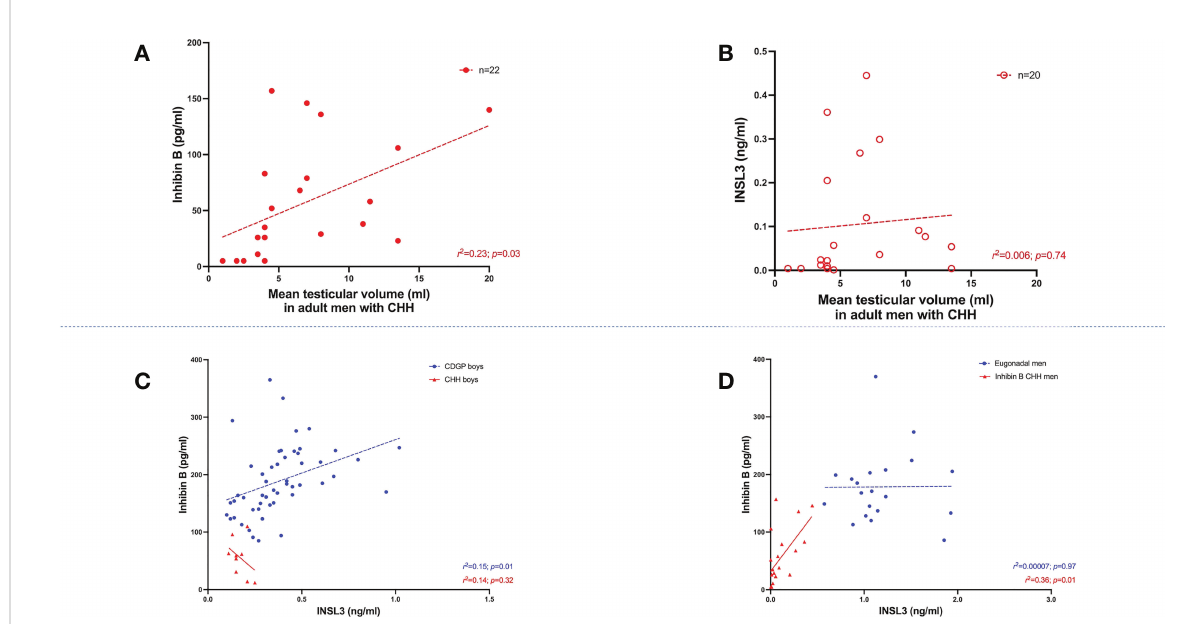
FIGURE 2 (A) Relationship between INB (pg/ml) and mean testicular volume (ml) in adult men with CHH ( n =22). Simple linear regression r 2 = 0.23; p =0.03. (B) Relationship between INSL3 (ng/ml) and mean testicular volume (ml) in adult men with CHH ( n =20). Simple linear regression r 2 = 0.006; p =0.74. (C) Relationship between basal INSL3 (ng/ml) levels over INB (pg/ml) in boys with CDGP (blue circles) and CHH (red triangles). Simple linear regression r 2 = 0.15; p =0.01 in CDGP (blue dotted line). Simple linear regression r 2 = 0.14; p =0.32 in CHH (red solid line). (D) Relationship between basal INSL3 (ng/ml) levels over INB (pg/ml) in eugonadal men (blue circles) and men with CHH (red triangles). Simple linear regression r 2 = 0.00007; p =0.97 in eugonadal men (blue dotted line). Simple linear regression r 2 = 0.36; p =0.01 in men with CHH (red solid